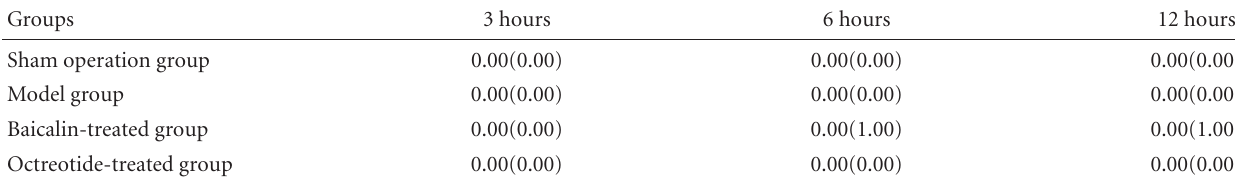
Table 10: Comparison of Caspase-3 protein expression in all groups ( M ( Q R